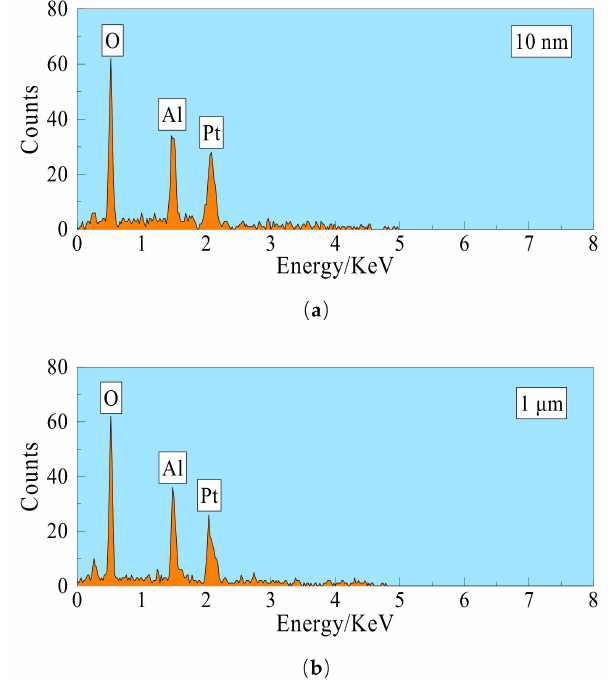
Figure 4. Energy-dispersive X-ray spectroscopy spectra of ceramic membrane sample. ( a ) 10 nm ceramic membrane. ( b ) 1 µ m ceramic